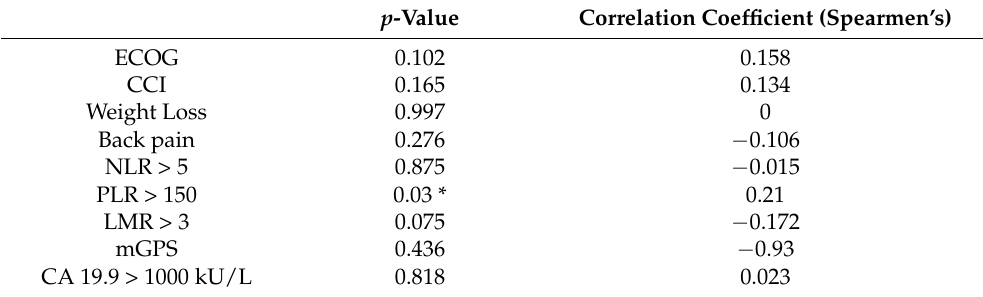
Table 2. Clinical and inflammatory predictive markers correlation with tumour viability. p -Value Correlation Coefficient